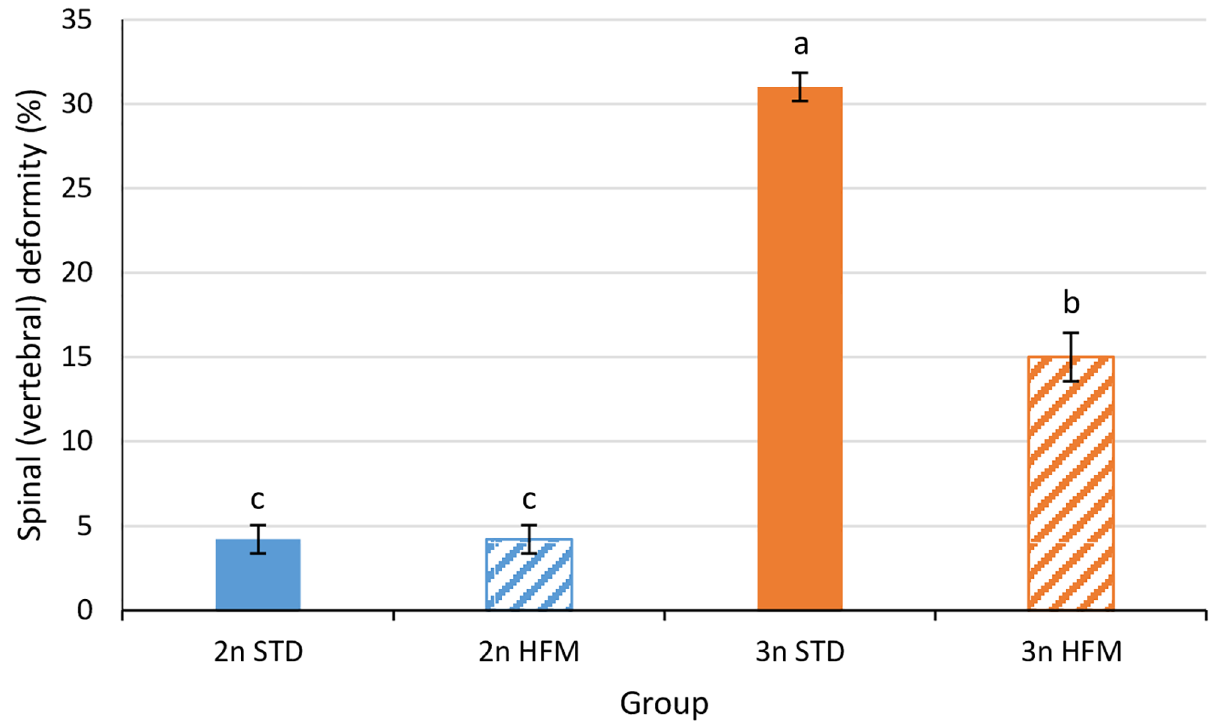
Fig 6. Percentage of vertebral deformities in salmon smolt detected by radiography. Percentages of fish with spinal (vertebral) deformity among diploid (2n) and triploid (3n) Atlantic salmon, Salmo salar , smolt (2745 ddPSF) fed fish meal (STD) and hydrolyzed fish protein (HFM) diets. Different letters denote significant differences ( P < 0.05). Data are presented as mean ± SEM (n = 3).